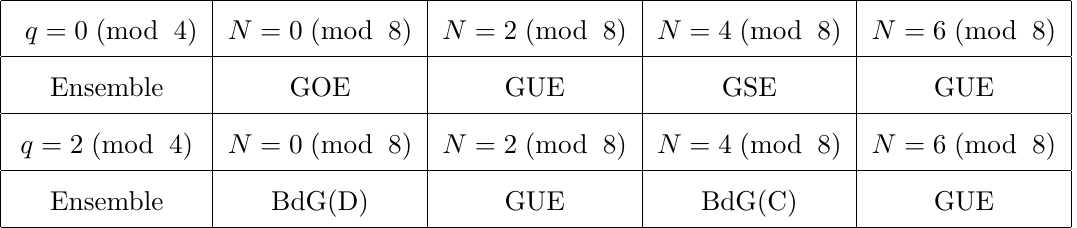
Table 2 . Random Matrix Classi(cid:12)cation of SYK Models: q = 0 ; 2 (mod 4) ( q = 4). where (cid:12) = 1 ; 2 or 4 for GOE, GUE or GSE, respectively, and Z